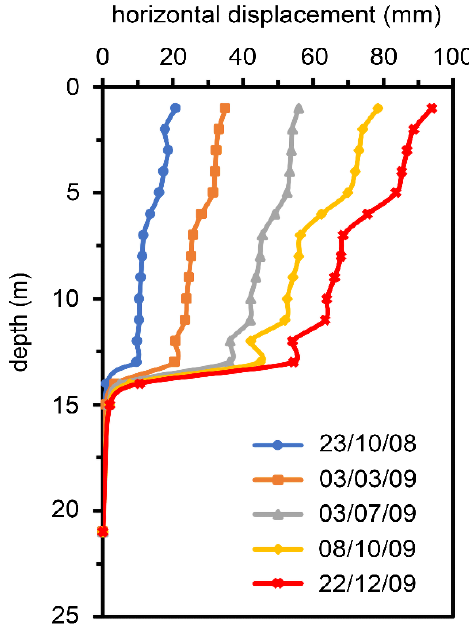
Figure 7. Horizontal displacement profiles recorded at the head of inclinometer BH4 located in the landslide body, whose position is indicated in Figure